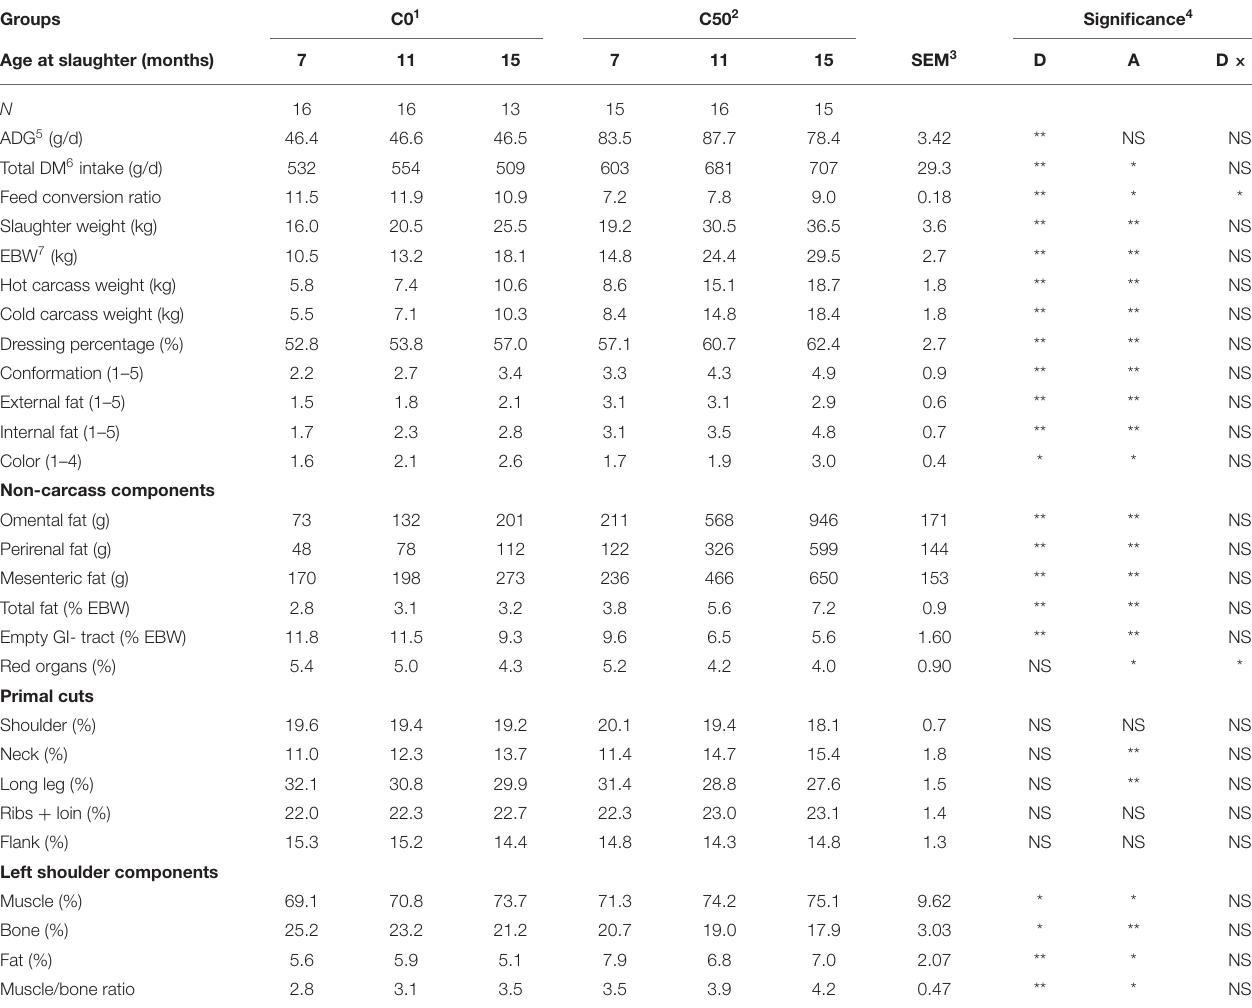
TABLE 2 | Growth performances and carcass traits of Creole goats according to diet and age at slaughter. Groups C0 1 C50 2 Significance